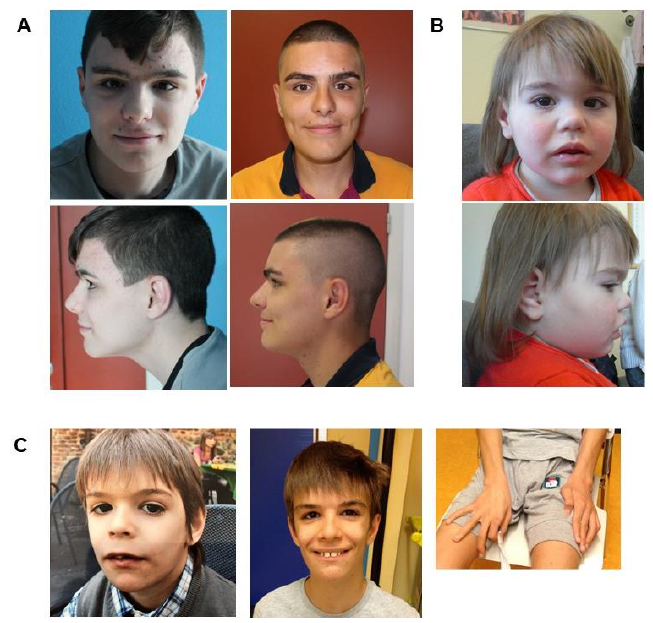
Figure 1. Dysmorphic features of patients with WAC mutations. ( A ) Patient 1 at the age of 14 (first column) and 16 years (second column). Note the protruding supraorbital ridges with bushy eyebrow and long eyelashes, deep-set eyes, bulbous nasal tip, short philtrum, and wide mouth. ( B ) Patient 2 at the age of three. Note: strabismus, short nose with markedly anteverted nares, upper lip with marked cupid bow. ( C ) Patient 3 at the age of eight (first column) and 17 years (second column). Note the square-shaped face with broad forehead, a broad nasal bridge, deep-set eyes with long down slanting palpebral fissures, long eyelashes, bushy eyebrows with mild synophrys, flat philtrum, and thin upper lip. The photo of the hands (bottom) shows the long fingers and his stereotypies consisting of rolling objects and toys.